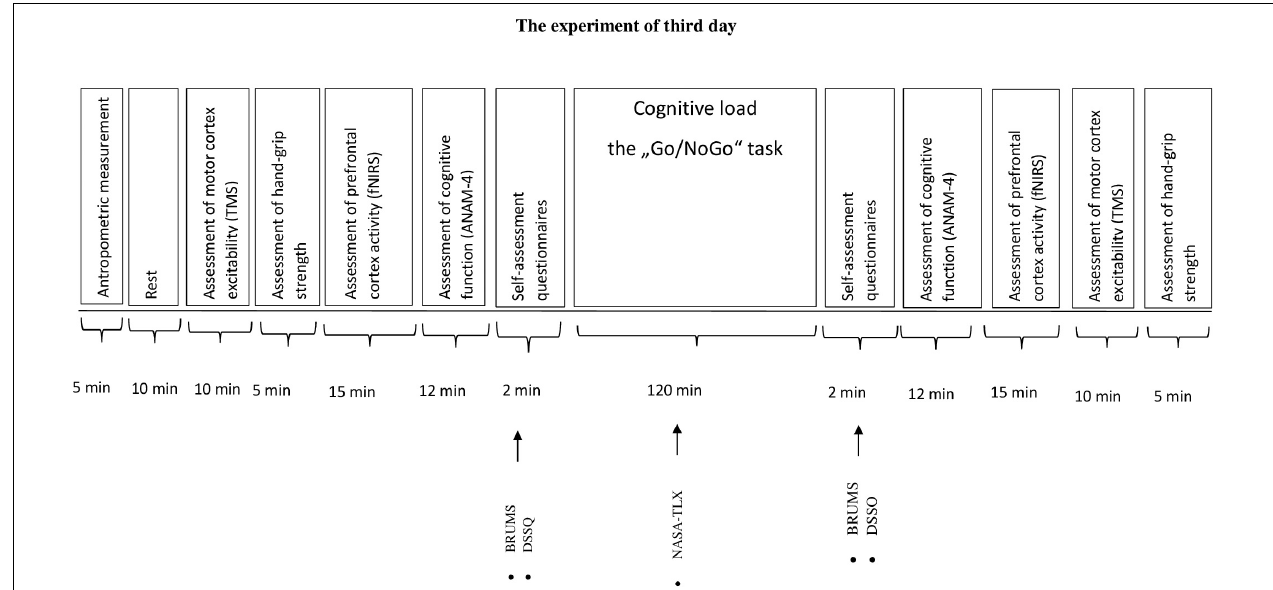
FIGURE 1 | The experiment of third day. BRUMS, Brunell Mood Scale; DSSQ, Dundee Stress State Questionmaire; NASA-TLX, National Aeronautics and Task Load